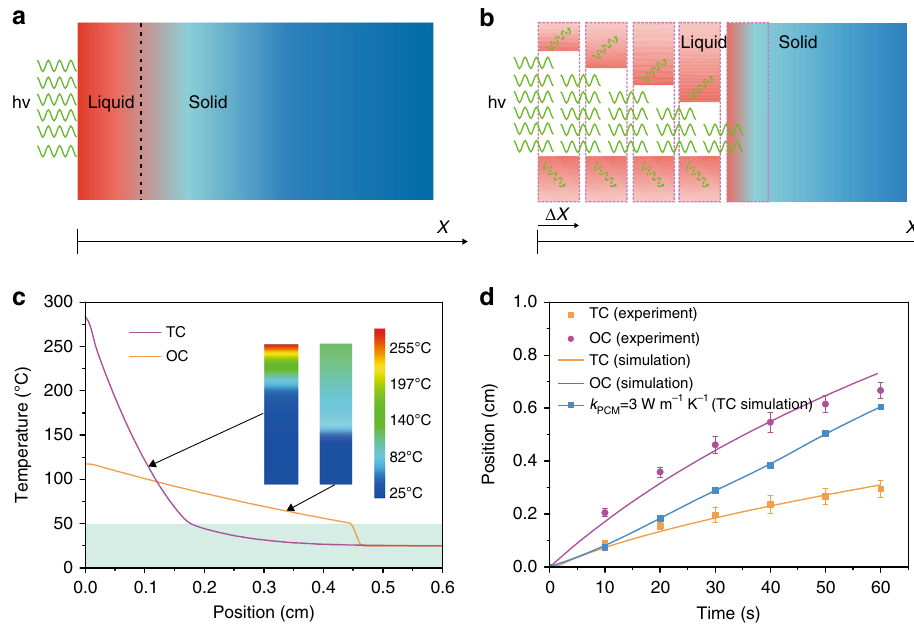
Fig. 3 Theoretical modeling of the charging of paraf fi n-Fe 3 O 4 @graphene composites. a Simulation schematic of thermal charging (TC) process. A constant heat fl ux converted from laser illumination is applied as the fi xed heat source to charge PCM via thermal diffusion. b Simulation schematic of optical charging (OC) process for the non-transparent solid paraf fi n composites. The whole sample is divided into numerous domains and is melted step by step. c Simulated temperature distribution pro fi les after charging for 30 s. d Simulation of solid/liquid interface propagation and comparison to experiments. The solid/liquid interface movement of thermally charged paraf fi n composites with a hypothetical thermal conductivity of 3 W m − 1 K − 1 (blue line) was simulated for